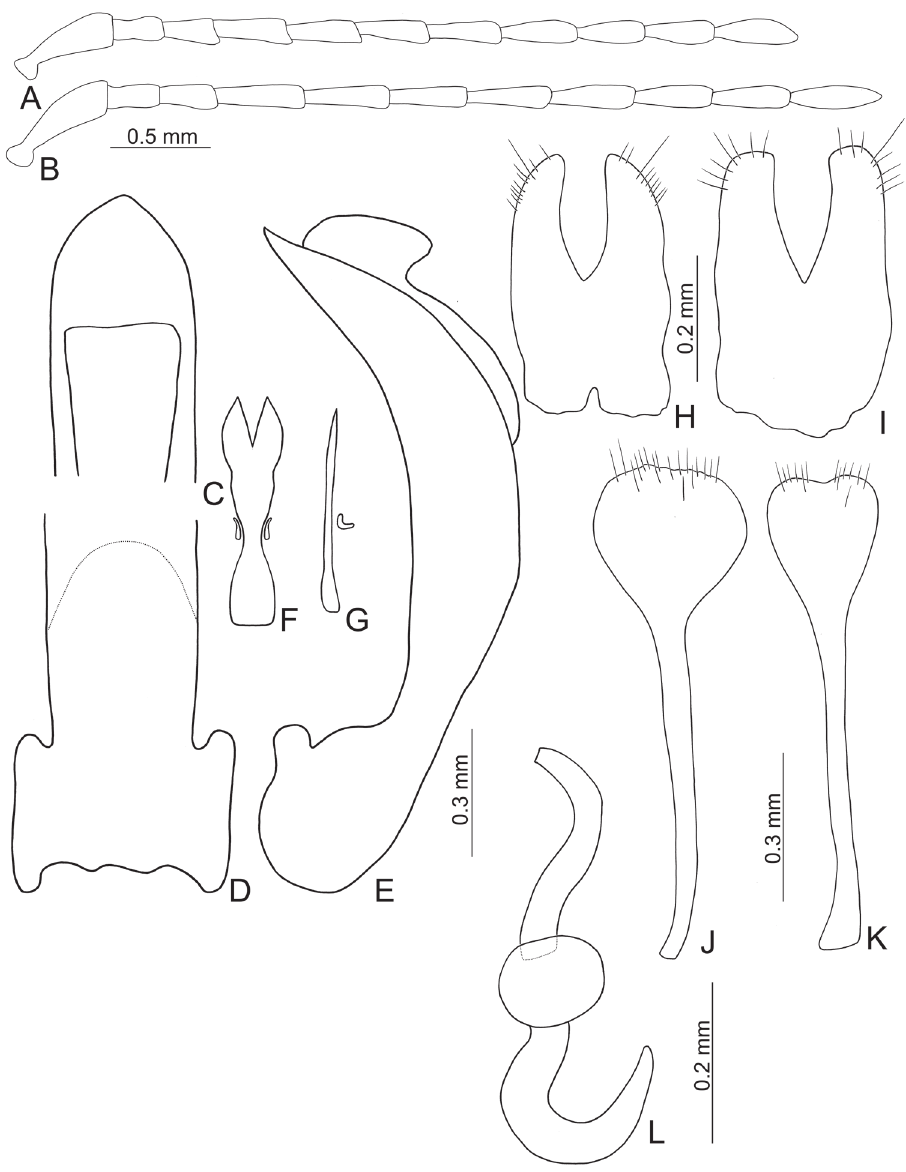
Figure 7. Diagnostic characters of Taiwanoshaira taipingshanensis sp. nov. A antenna, male B antenna, fe- male C penis, apex, dorsal view D penis, base, dorsal view E penis, lateral view F endophallic sclerites, dorsal view G ditto, lateral view H gonocoxae, from Yuanyanghu ( 鴛鴦湖 ) I same, from Taipingshan ( 太平山 ) J abdominal ventrite VIII, from Yuanyanghu ( 鴛鴦湖 ) K same, from Taipingshan ( 太平山 ) L